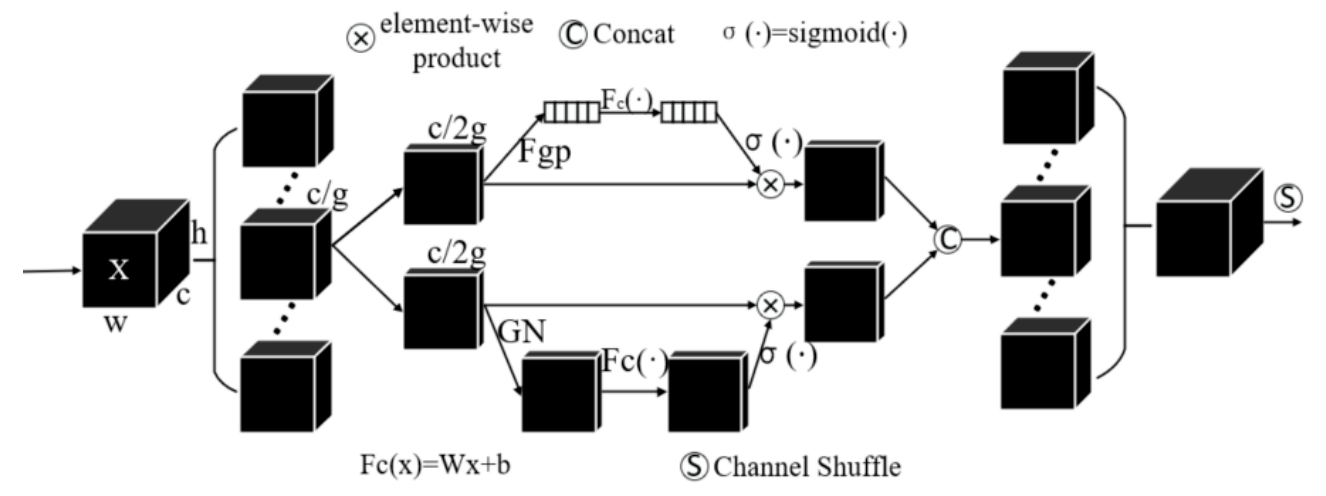
Figure 6. The structure of CSMA.